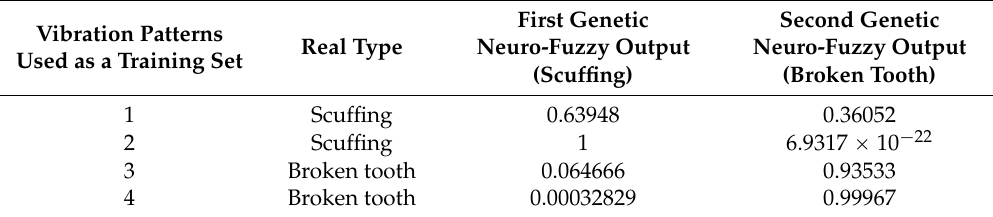
Table 4. Output values of the Genetic Neuro-Fuzzy system for the testing